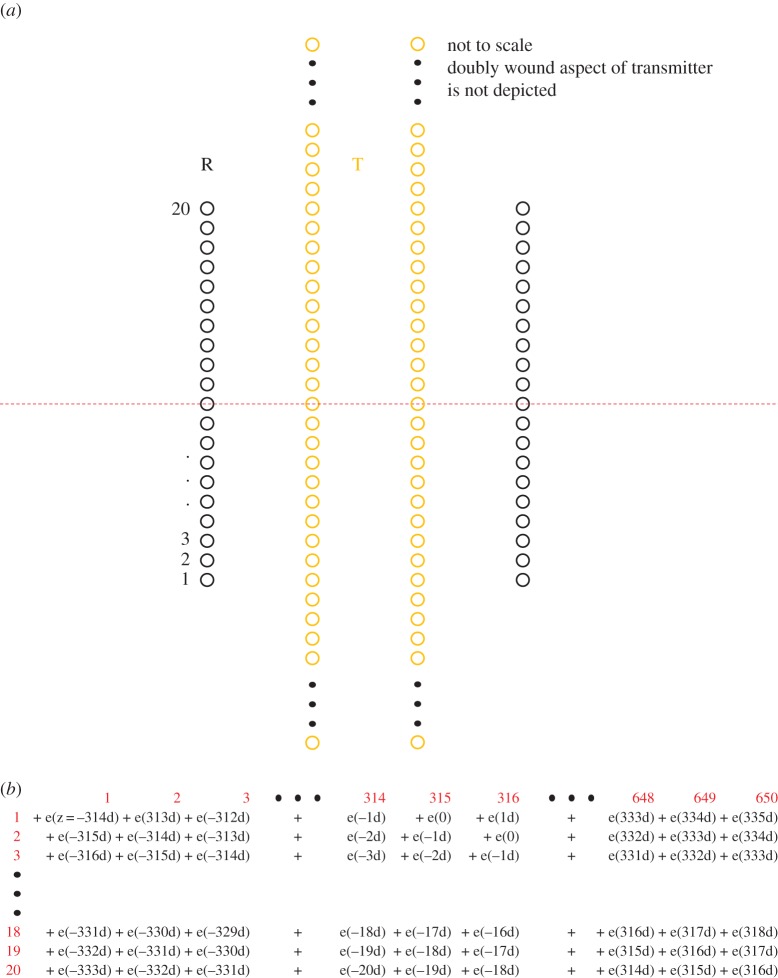
(a) Sketch shows the positions of individual turns in the transmitter–receiver coil arrangement. (b) An expansion of the matrix from equation (3.6) to illustrate the summation procedure. (Online version in colour.)